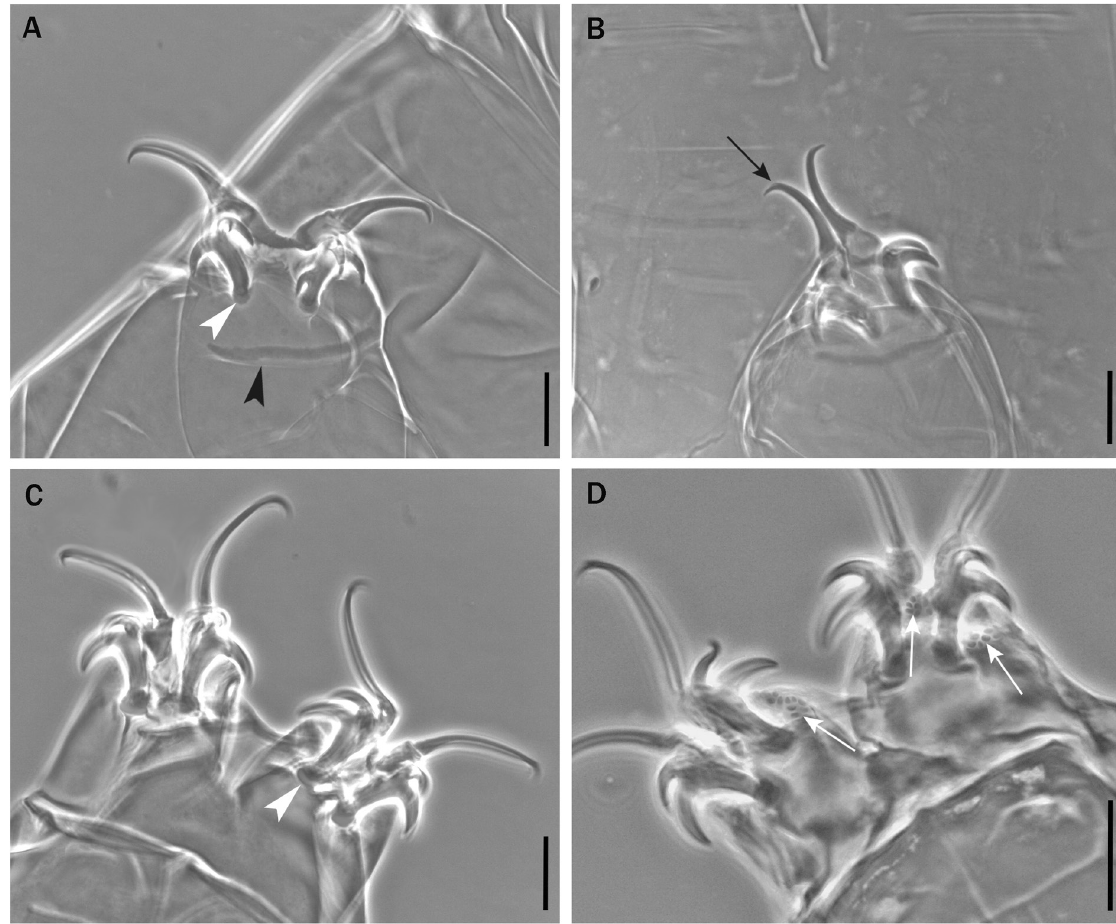
Fig. 18. Milnesium irenae sp. nov. A, C . Holotype, ♀ (slide No. UNLPam 1657-1). B . Paratype, ♀ (UNLPam 1430-3). D . Paratype, ♀ (slide No. UNLPam 1603-3). Claws and leg characters. A . Leg II; the white arrowhead indicates a lunule, the black arrowhead indicates the leg cuticular bar. B . Legs II; the black arrow indicates primary branch accessory points. C . Legs IV; the white arrowhead indicates a lunule. D . Legs IV, magnified; the white arrows indicate some tubercles. Scale bars = 10